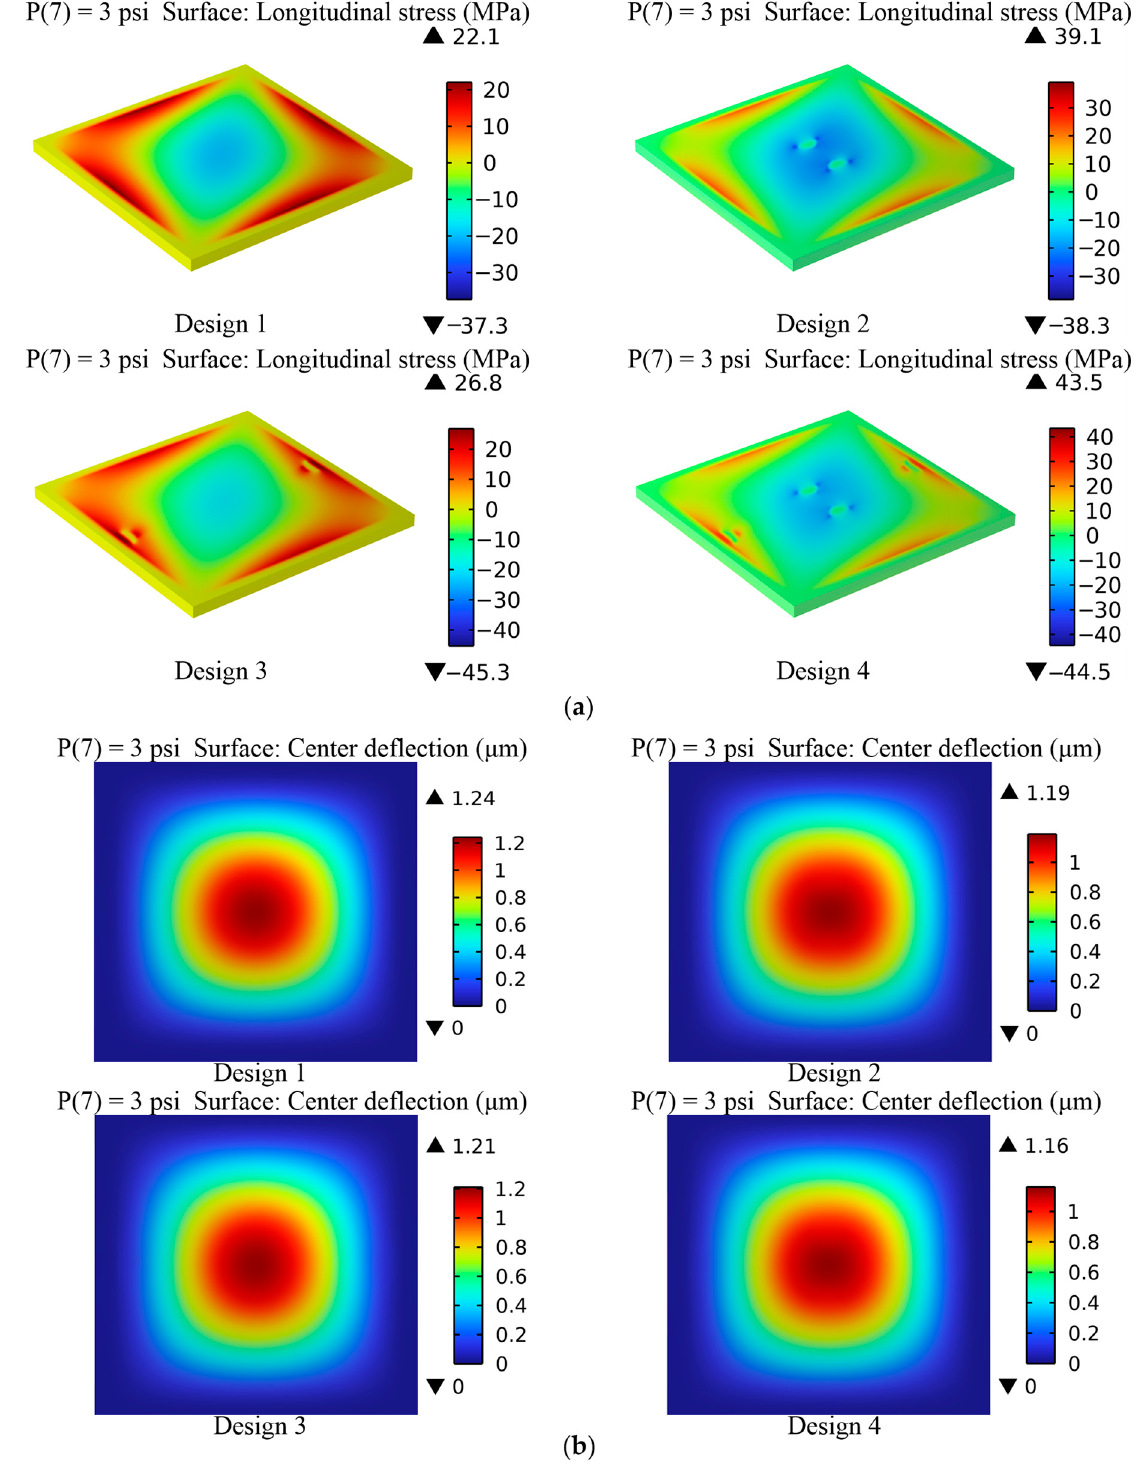
Figure 5. ( a ) The longitudinal stress of the four distinct constructions at 3 psi; and ( b ) the center deflection of the four distinct constructions at 3 psi.